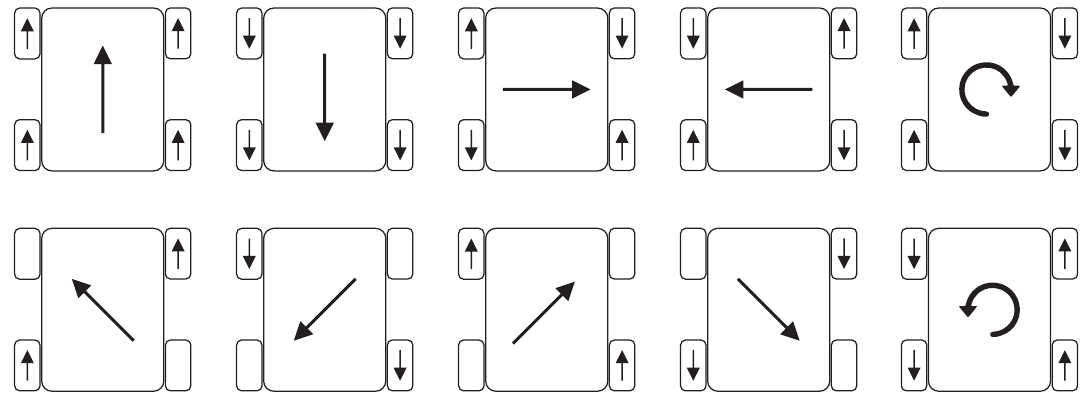
Figure 11: Motions of omnidirectional